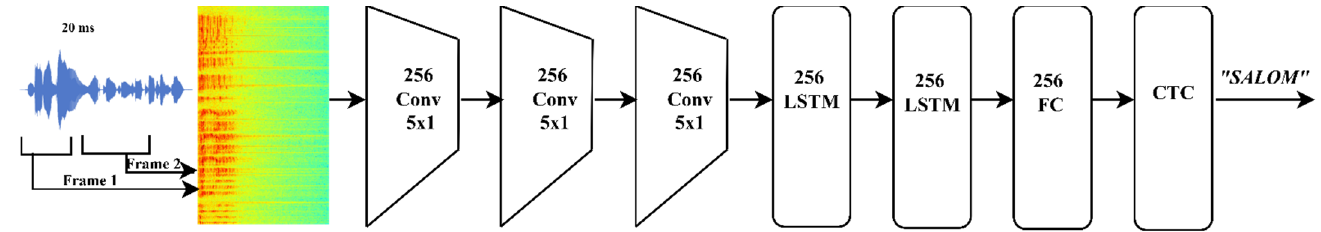
Figure 1. The proposed network architecture. Table 1. Layer parameters of the proposed network model.